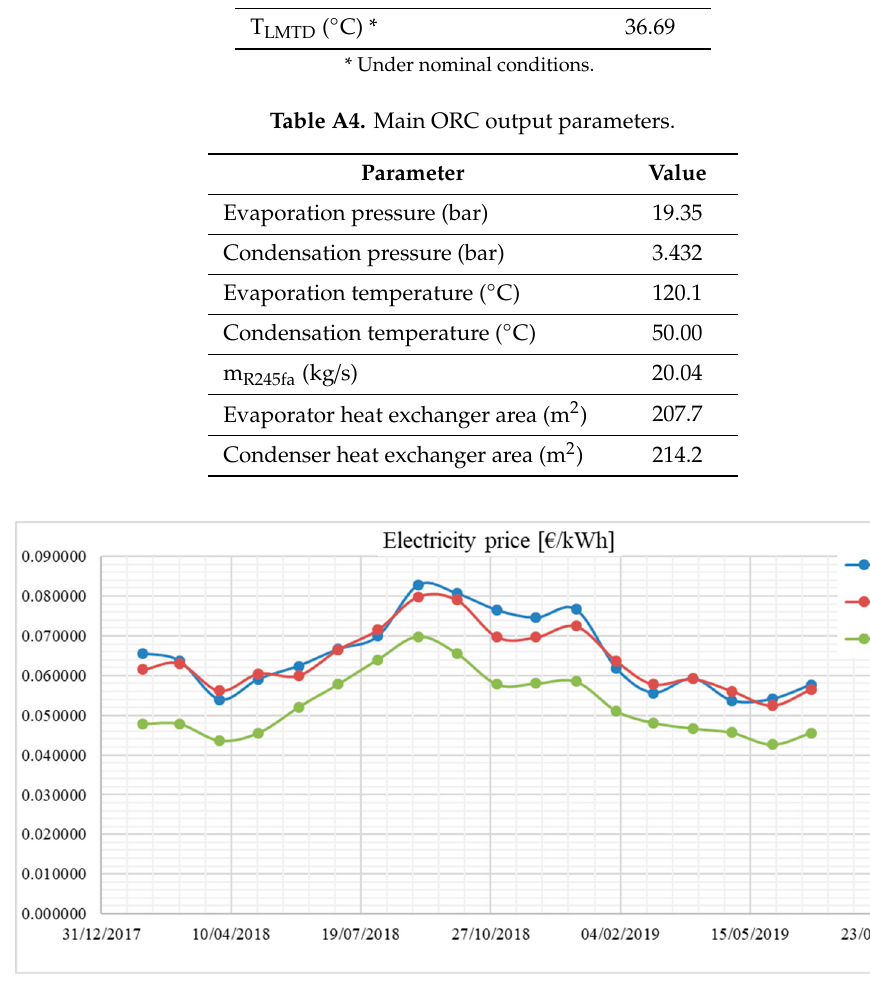
Figure A1. Electricity price from January 2018 to August 2019 for every partition (F1, F2, and F3) of the time-dependent tariff.